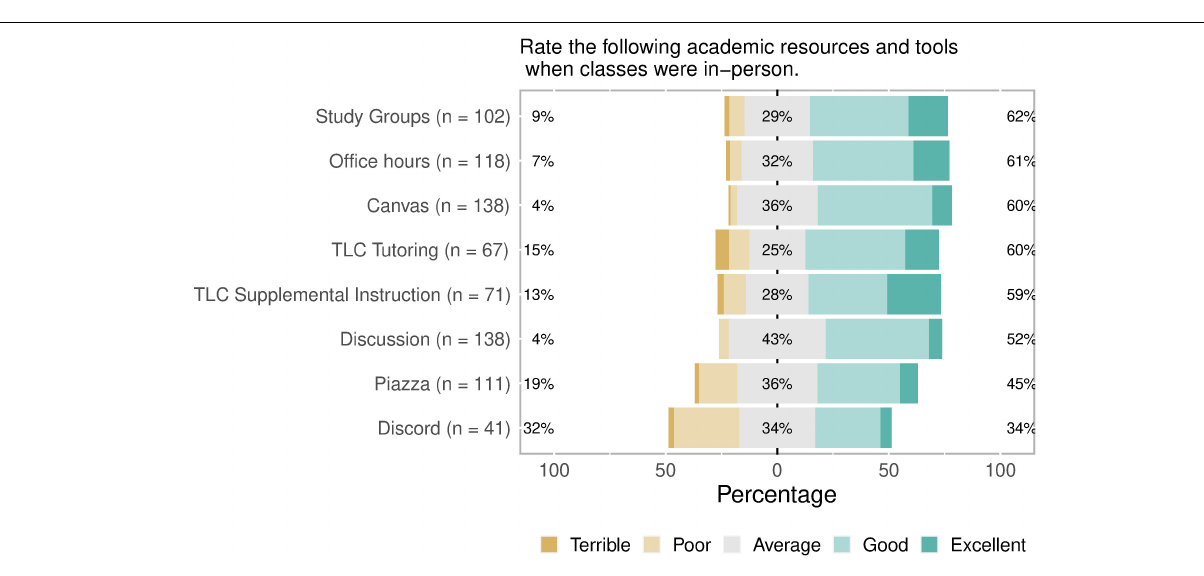
FIGURE 4 | Students’ reported approval of certain possible interventions in online learning.